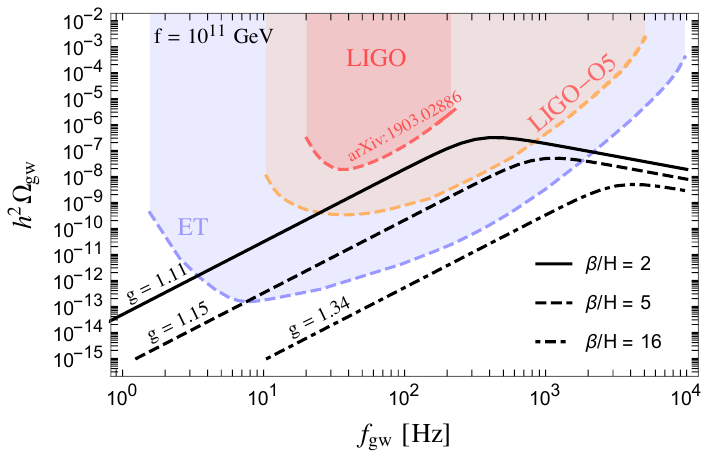
Figure 4 . Weakly coupled model. Predictions for the GW spectrum for three benchmark models in the gauge-dominance scenario. We also show the sensitivity curves of the LIGO (current bound [25] and projection of run O5) and the Einstein Telescope (ET) experiments. The same spectra can be realized in the purely quartic scenario with g = 0 and (cid:21) X = (cid:21) S = (0 : 34 ; 0 : 38 ; 0 : 50), respectively. Taking also into account the projected sensitivity of ET [34], one could be able to probe p . 0 : 5) characterised by nucleation temperatures regions of the model with g . 1 : 3 ( (cid:21) (cid:21) S X T =f . 10 (cid:0) 2 n